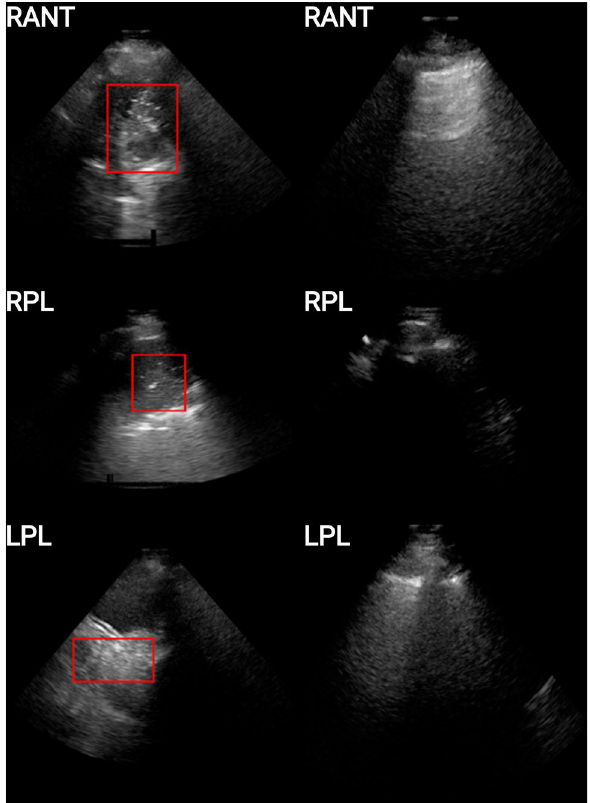
Figure 3. Examples of unhealthy (left column) and healthy (right column) patients for 3 scanning regions (viz. RANT, RPL, LPL). The unhealthy patients are those for which consolidation is present, and are depicted here with a red bounding box encompassing the imaging patterns associated with the pathology, while the healthy patients are those for which no imaging patterns associated with consolidation/collapse or other pathologies.